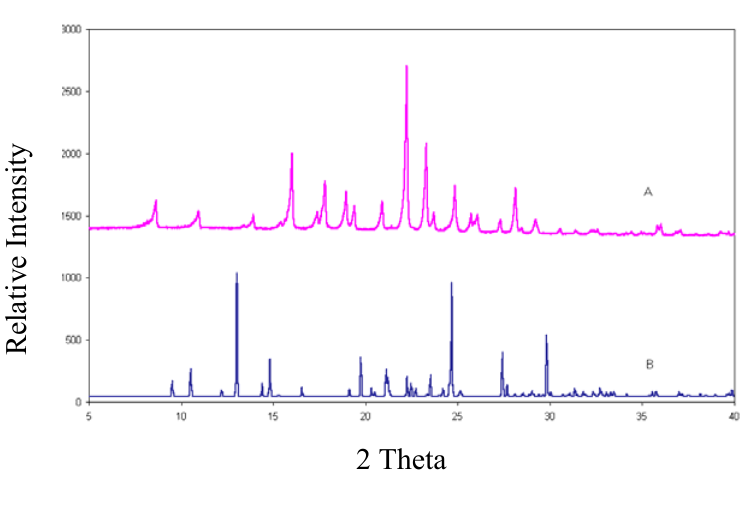
Figure 7. XRPD traces for rofecoxib (A) and I